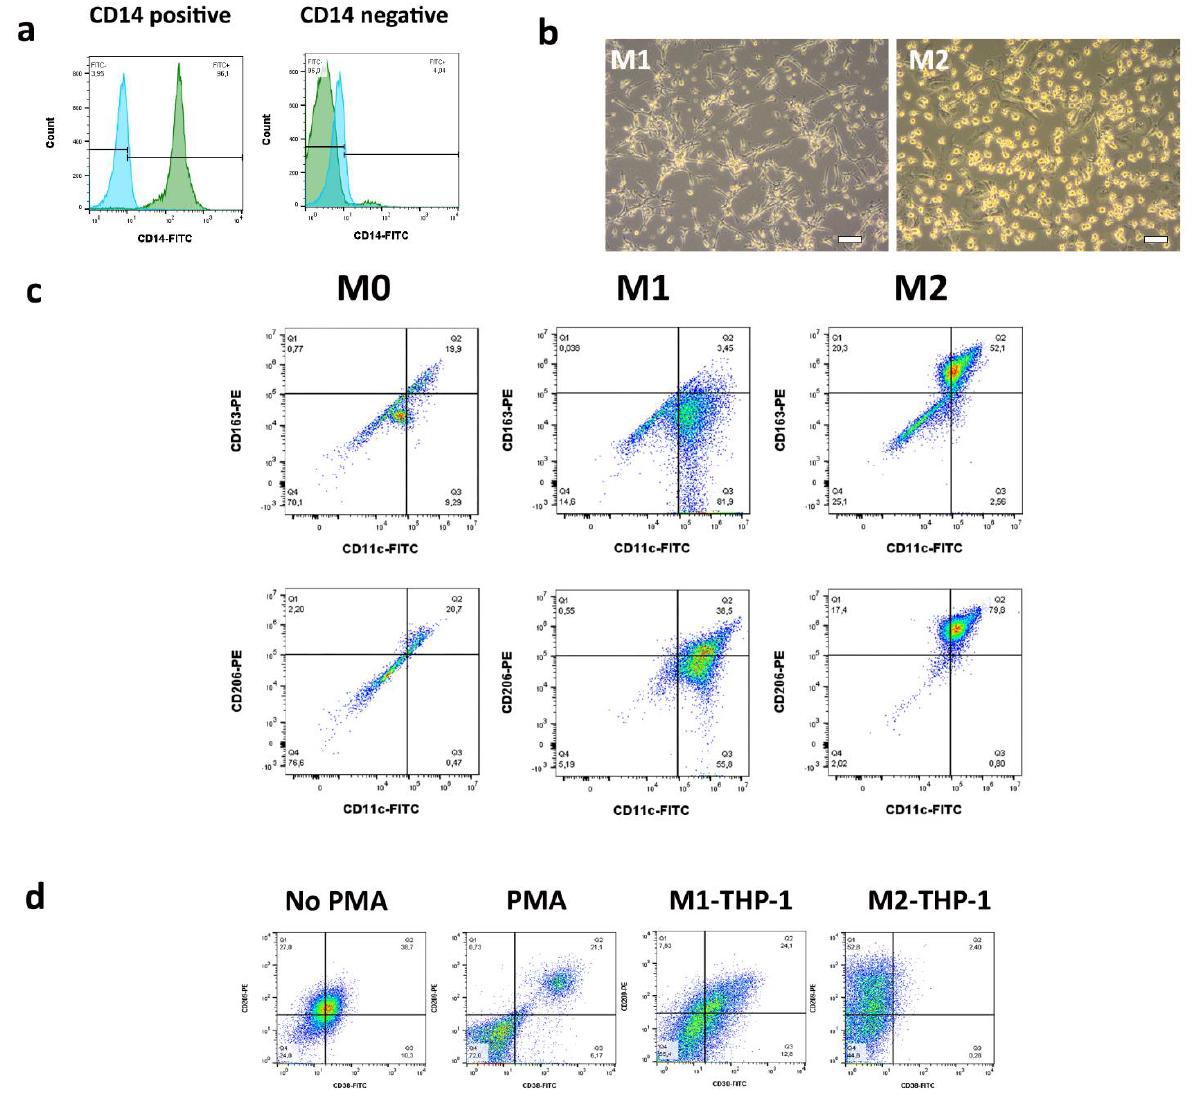
Figure 1. ( a ) CD14-positive (left) and -negative (right) PBMC fractions after magnetic bead separation. ( b ) Morphology of monocyte-derived M1 (left) and M2 (right) macrophages; scale bar = 20 µm. ( c ) CD163, CD206, CD11c cell surface marker expression in M0, M1, and M2-like macrophages. ( d ) CD38 and CD209 cell surface marker expression in non-differentiated THP-1 cells without PMA stimulation or PMA-stimulated and M1- and M2-differentiated THP-1 cells.